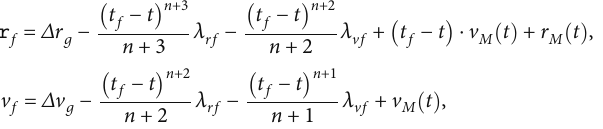
(1) Design maneuver model set M : given the minimum, k middle, and maximum values of each component of model parameter vector Equation (23), a total of N feasible maneuver modes are formed ̂ (2) Calculate target state estimation and model proba- X k ð ω i Þ : input radar measurement data sequence bility μ i k k ̂ and Z k and perform the evaluation of target state X k tions (37) and (35) (3) Online adjustment of model parameters ω i : through k ð ω i Þ obtained in Step (2), the model probability μ i k k combined with the adaptive grid adjustment rules Equations (40) – (42), the maneuver model parame- ters can be adjusted online (4) Calculation of target prediction trajectory envelope : calculate the target prediction trajectory envelopes S set using numerical integration Equations (8) – (12) for ð ω i Þ and evaluate the accu- each maneuver model M i k k racy of the prediction results in combination with the ð ω i Þ obtained in Step (2) model probability μ i k k ̂ Þ of the predicted intercept point: (5) Calculation X ð t p calculated according to the trajectory envelope S set in Step (4), select the maximum probability of ð ω i Þ and the fl ight time t of the the model μ i p k k interceptor and calculate the predicted intercept gration of Equation